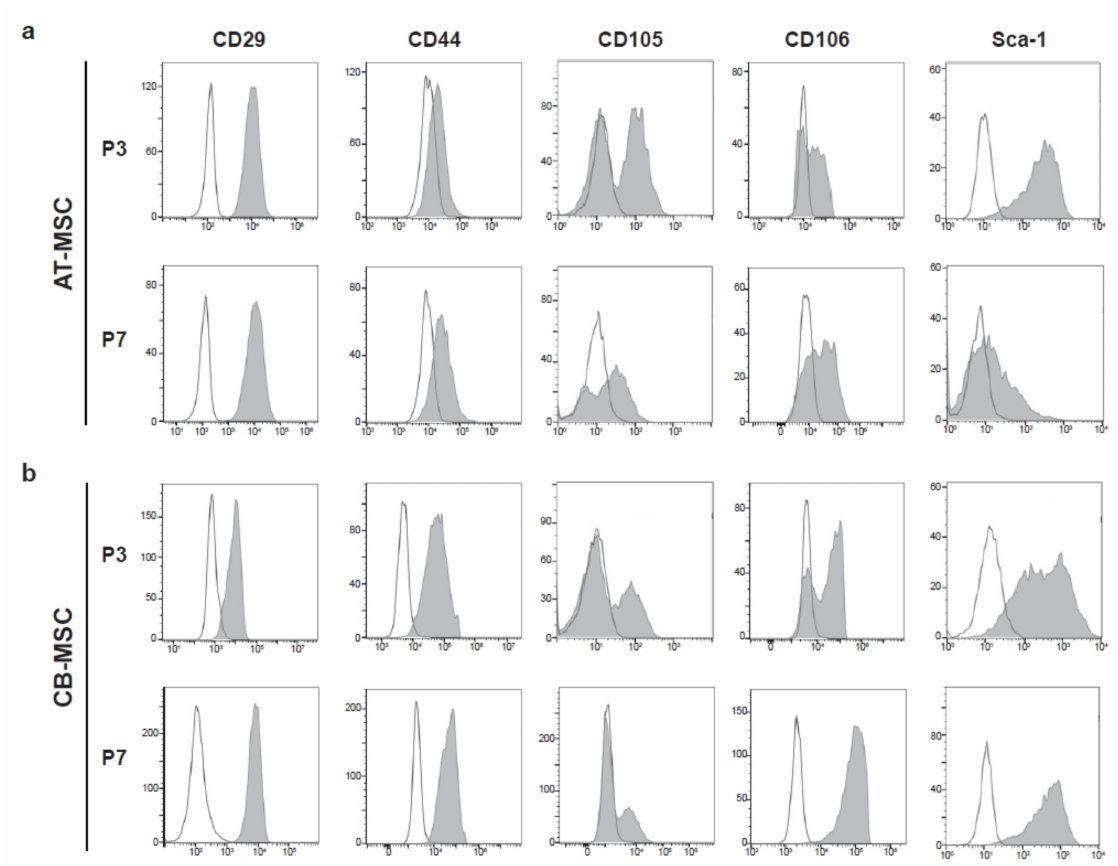
Figure 3. Immunophenotypes of MSCs. Cell surface markers for MSCs, CD29, CD44, CD105, CD106, and Sca-1 were used to characterize ( a ) AT-MSC and ( b ) CB-MSC at passage 3 (P3) and 7 (P7), respectively. Representative flow cytometry patterns were shown. Shaded peaks represent antibody-labeled population; blank peaks represented isotype